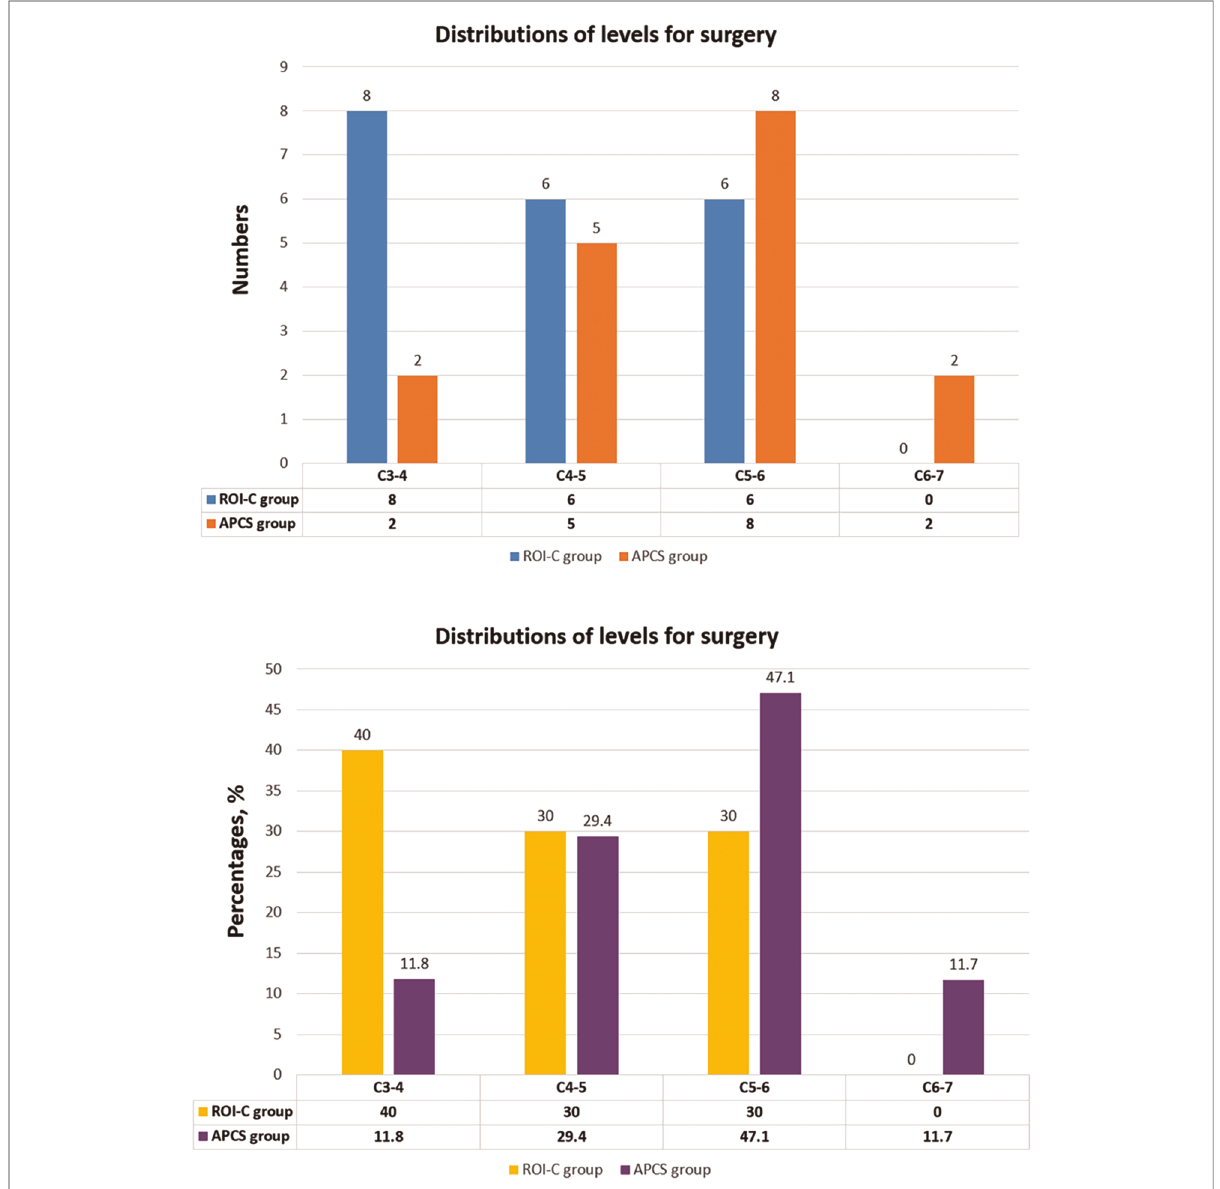
FIGURE 3 The distributions of levels for surgery in the ROI-C group and APCS group, exhibited as numbers and